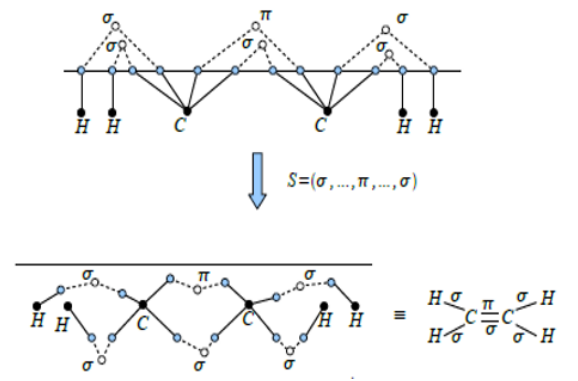
Fig. 5. Modeling a phosphodiester bond by splices It is possible to simulate hydrogen bonds in DNA and RNA that are responsible for the secondary structure by adding new types of elements (marked with yellow circles) into splices co-regions and convolutions between them. We also note another option for taking into account the differences in bonds using higher splices, when certain types of bonds are modeled by the corresponding splices included in the higher splices, which completely model the molecule. Let us illustrate the formation of water dimers and their models